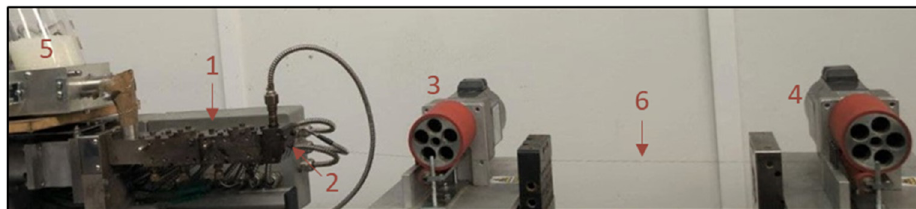
Figure 2. Extrusion setup: 1—Twin-screw extruder; 2—Extrusion die; 3—Drawing roll 1; 4—Drawing roll 2; 5—Feeder; 6—Filament.